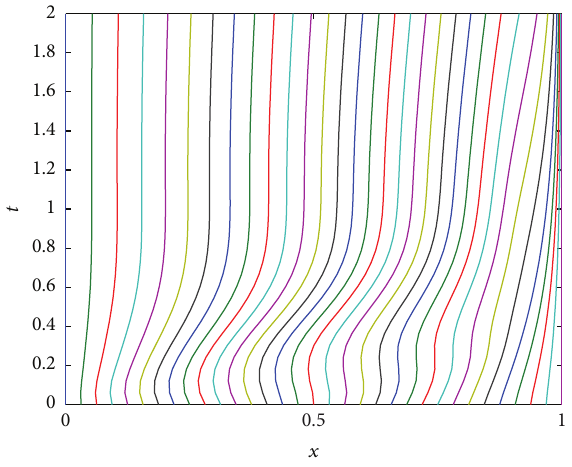
Figure 4: Mesh trajectory with 𝜀 = 2 −6 , 𝜏 = 0.5 , and 𝑁 = 32 .